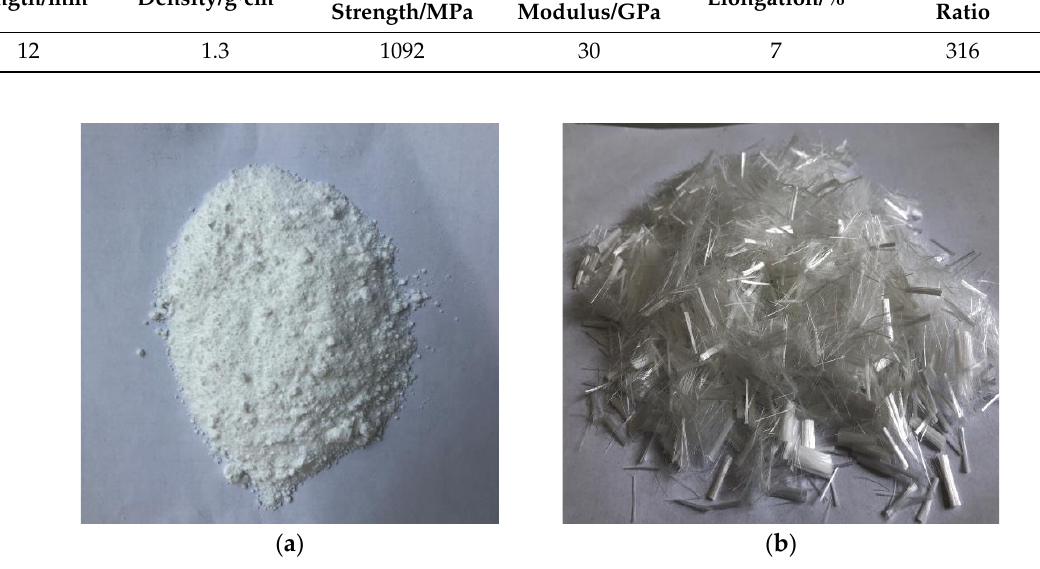
Figure 1. Appearance features of ( a ) NS and ( b ) PVA.